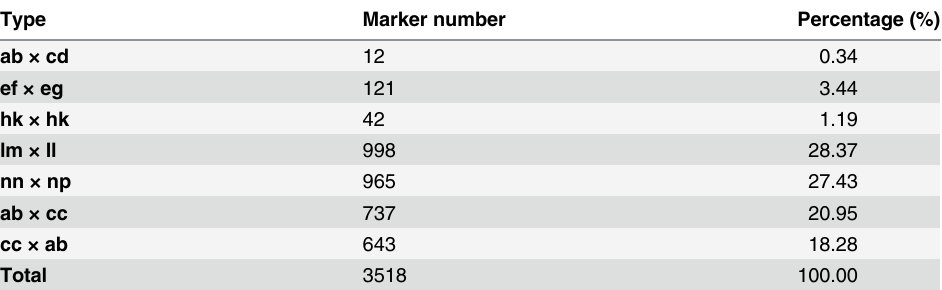
Table 2. Statistic of the segregation types for SLAF